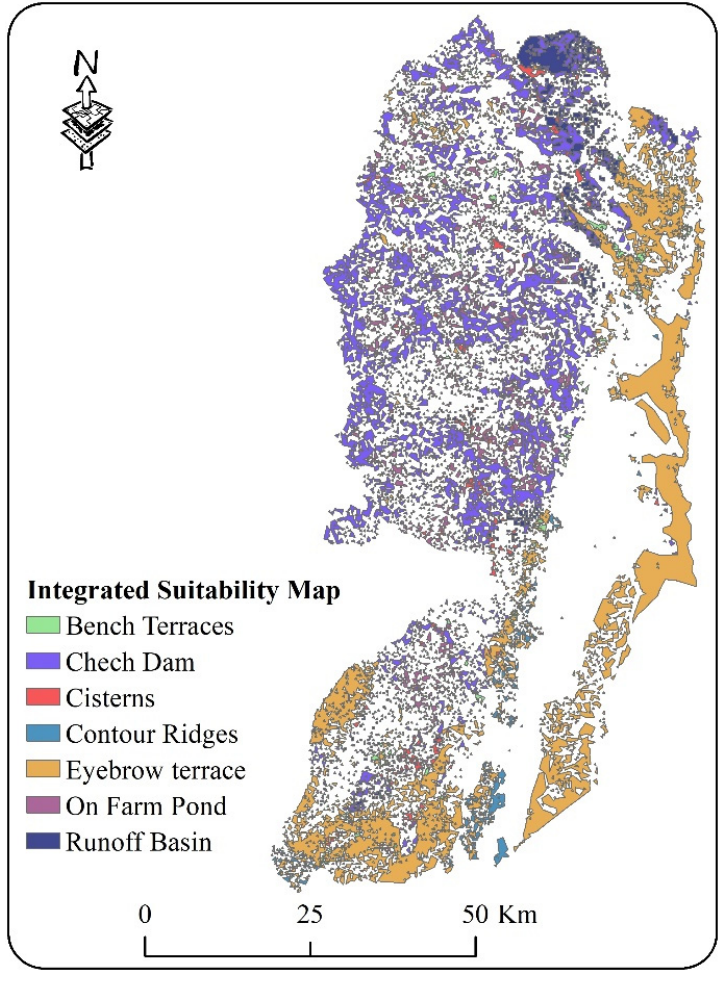
Figure 5. Integrated suitability map of all the seven RWHts for the WB, Palestine.